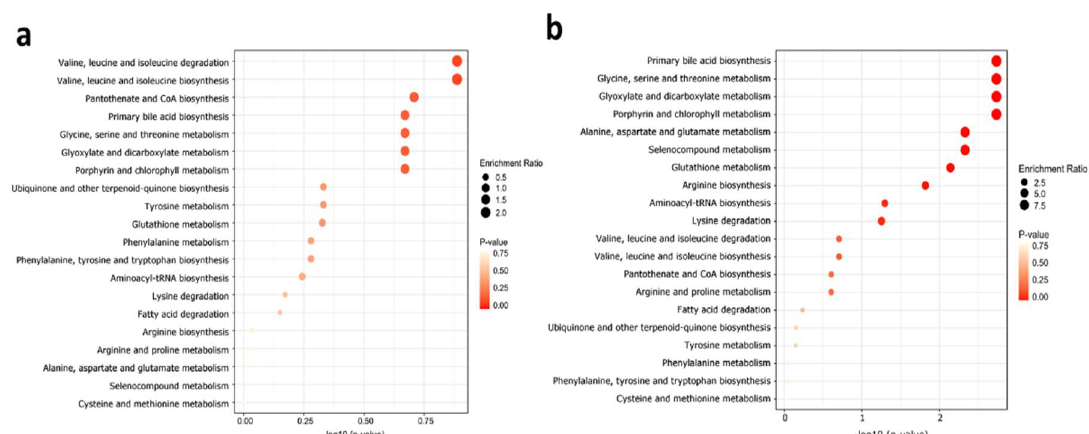
Figure 4. Dot plot of enriched metabolite pathway affected by VAI and sex. ( a ) Male VAI_1 (reference group), compared to VAI_2 and VAI_3 groups. ( b ) Female VAI_1 (reference group), compared to VAI_2 and VAI_3 groups. Colors indicate the p -values and the circles’ size based on the enrichment ratio.